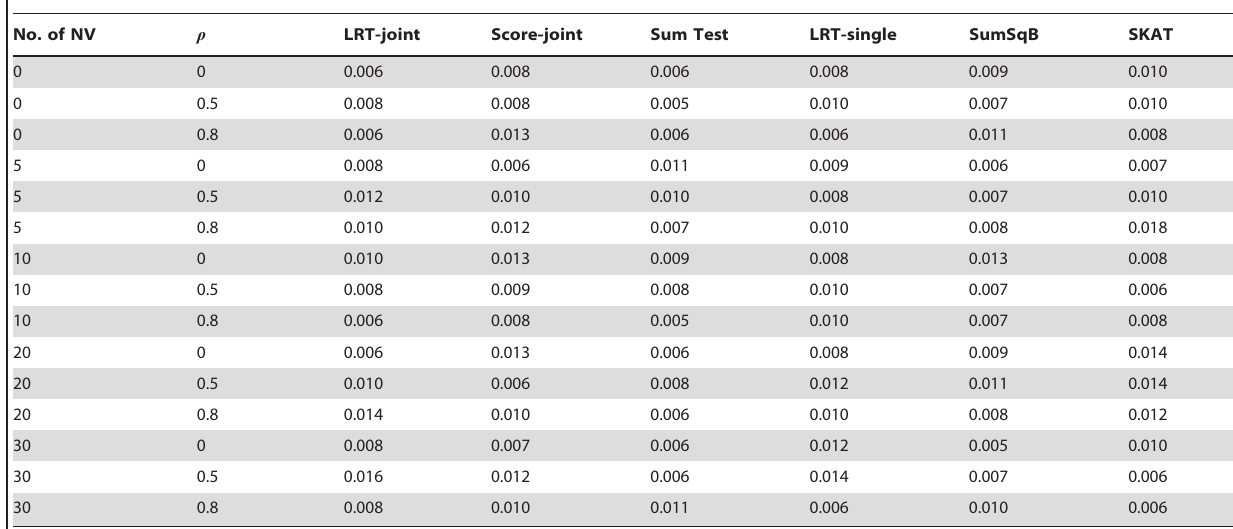
Table 3. Type I error rate for all tests: binary trait, a ~ 0 : 01 .